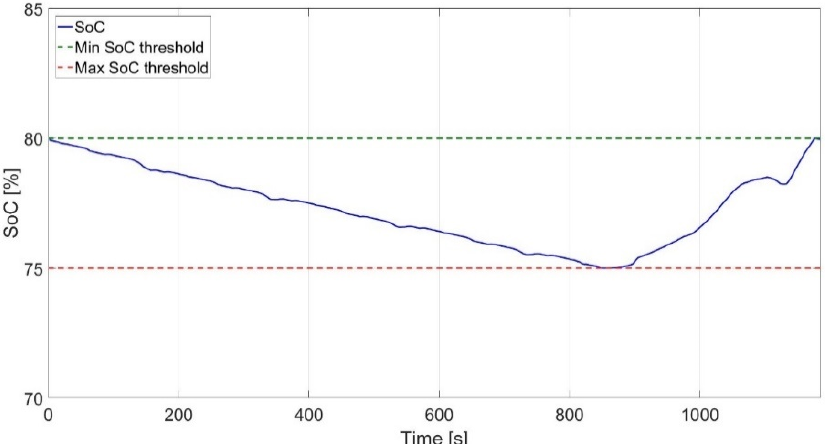
Figure 19. SoC trend, LPF-based EMS.